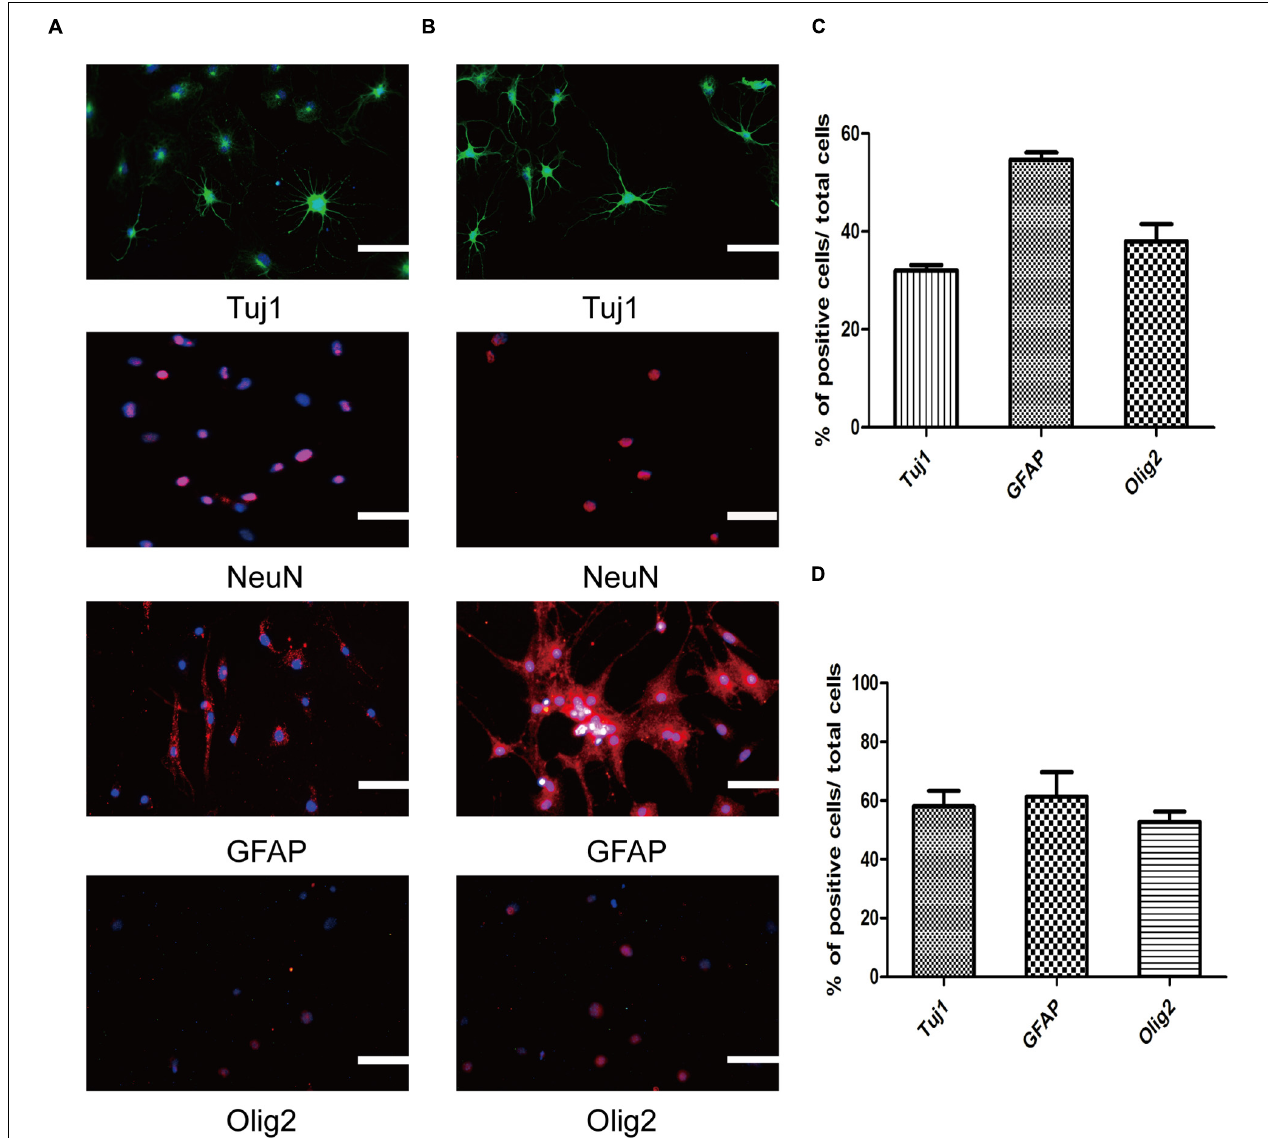
FIGURE 3 | Three neural lineages differentiation potential of SMSINS in vitro . (A) Differentiation potential of SMSINS without growth factors, identified by immunostaining with antibodies against Tuj1 (Green), NeuN (Red), GFAP (Red), and Olig2 (Red). Nuclei were counterstained with DAPI (blue). (B) Specific differentiation of neurons, astrocytes, and oligodendrocytes from SMSINS, as determined by immunostaining with antibodies against Tuj1 (Green), NeuN (Red), GFAP (Red), and Olig2 (Red). Nuclei were counterstained with DAPI (blue). (C,D) Quantification of neurons, astrocytes, and oligodendrocytes differentiated from SMSINS. All data are represented as the mean ± SEM. Scale bars: 100 µ m (A,B)